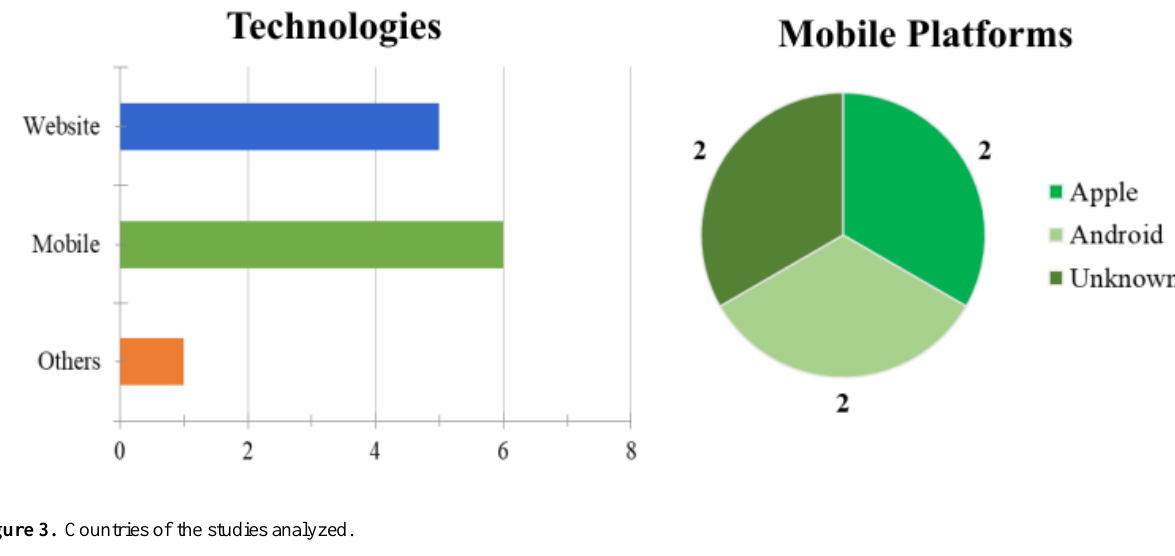
Figure 3. Countries of the studies